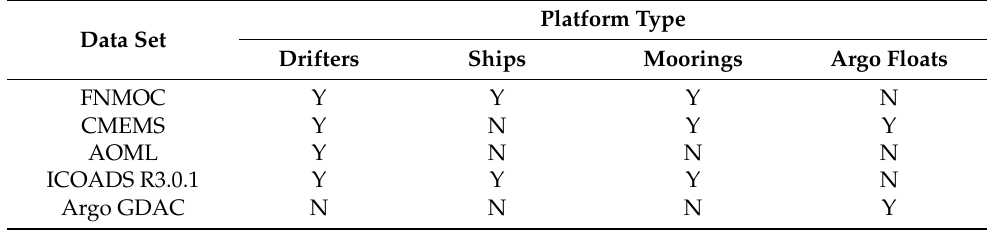
Table 1. The platform types included in each data set in this study. Y stands for Yes and N for No. Platform Type Data Set Drifters Ships Moorings Argo